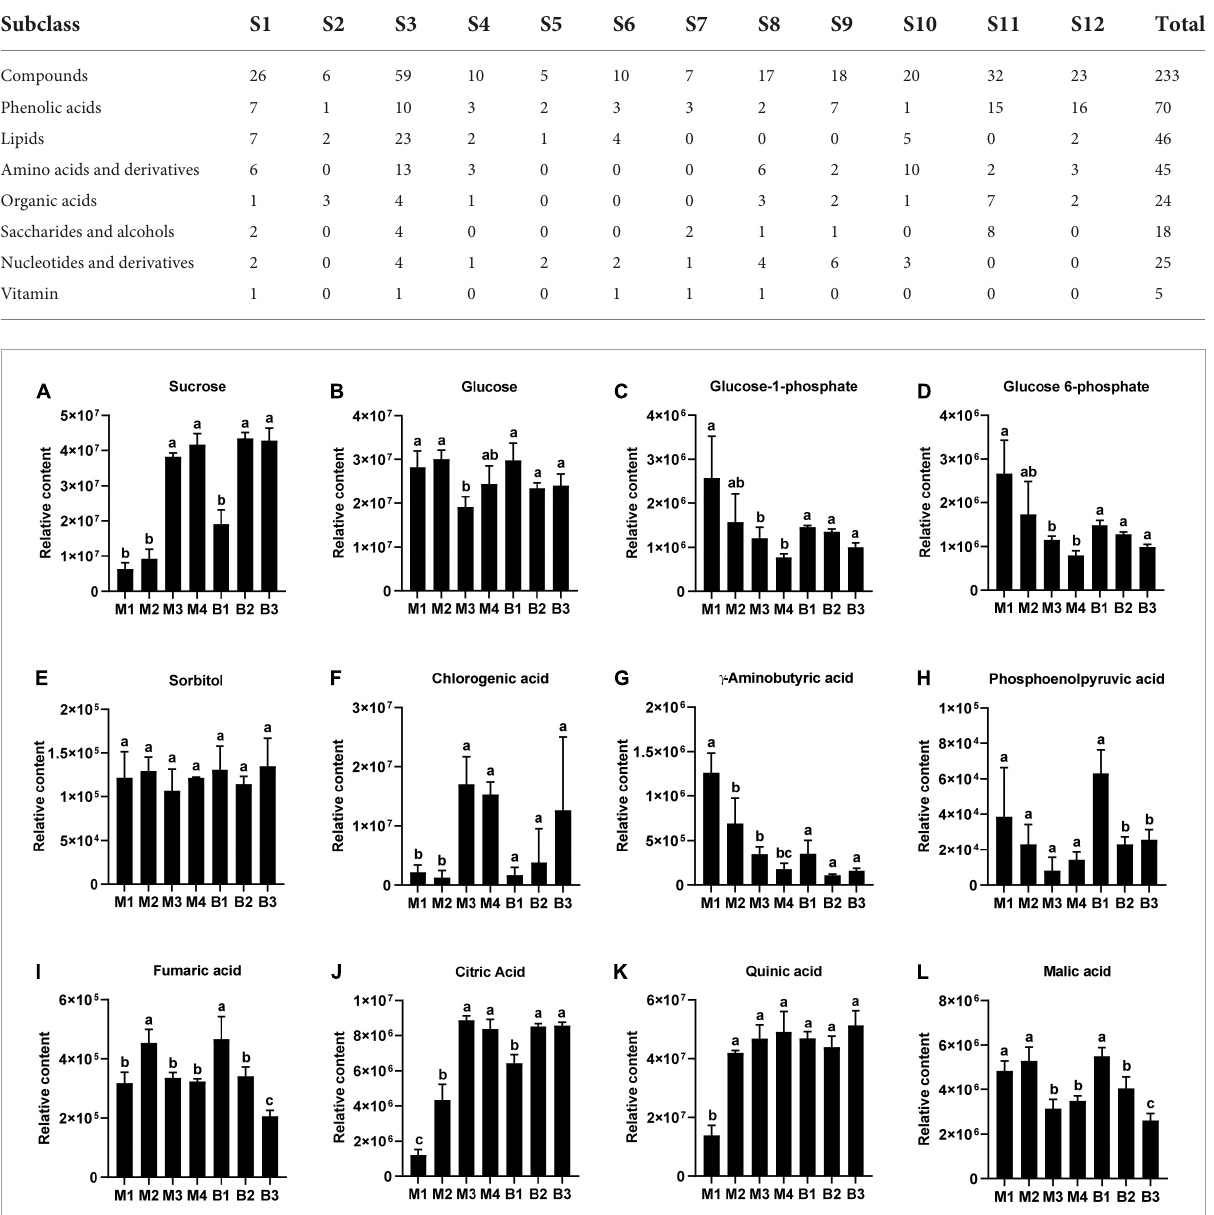
FIGURE3 Changes in the relative contents of the main sugars and organic acids in pineapple fruits at four different stages (40, 80, 100, and 120 DAA) for M (M1, M2, M3, and M4) and three different stages (40, 80, and 100 DAA) for B (B1, B2 and B3). (A) Sucrose, (B) glucose, (C) glucose 1-phosphate, (D) glucose 6-phosphate, (E) sorbitol, (F) chlorogenic acid, (G) gamma-aminobutyric acid, (H) phosphoenolpyruvic acid, (I) fumaric acid, (J) citric acid, (K) quinic acid, (L) malic acid. For each cultivar, bars with the same lowercase letter (a, b, or c) indicate no significant differences ( p <